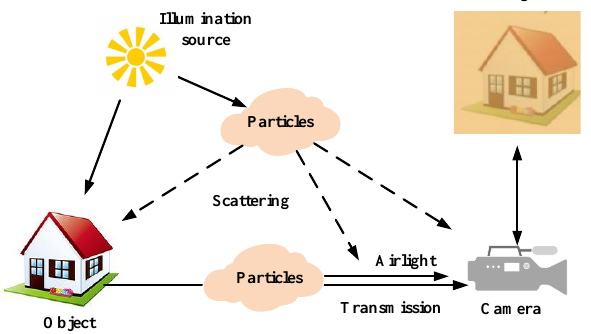
Figure 1. Formation model for degraded